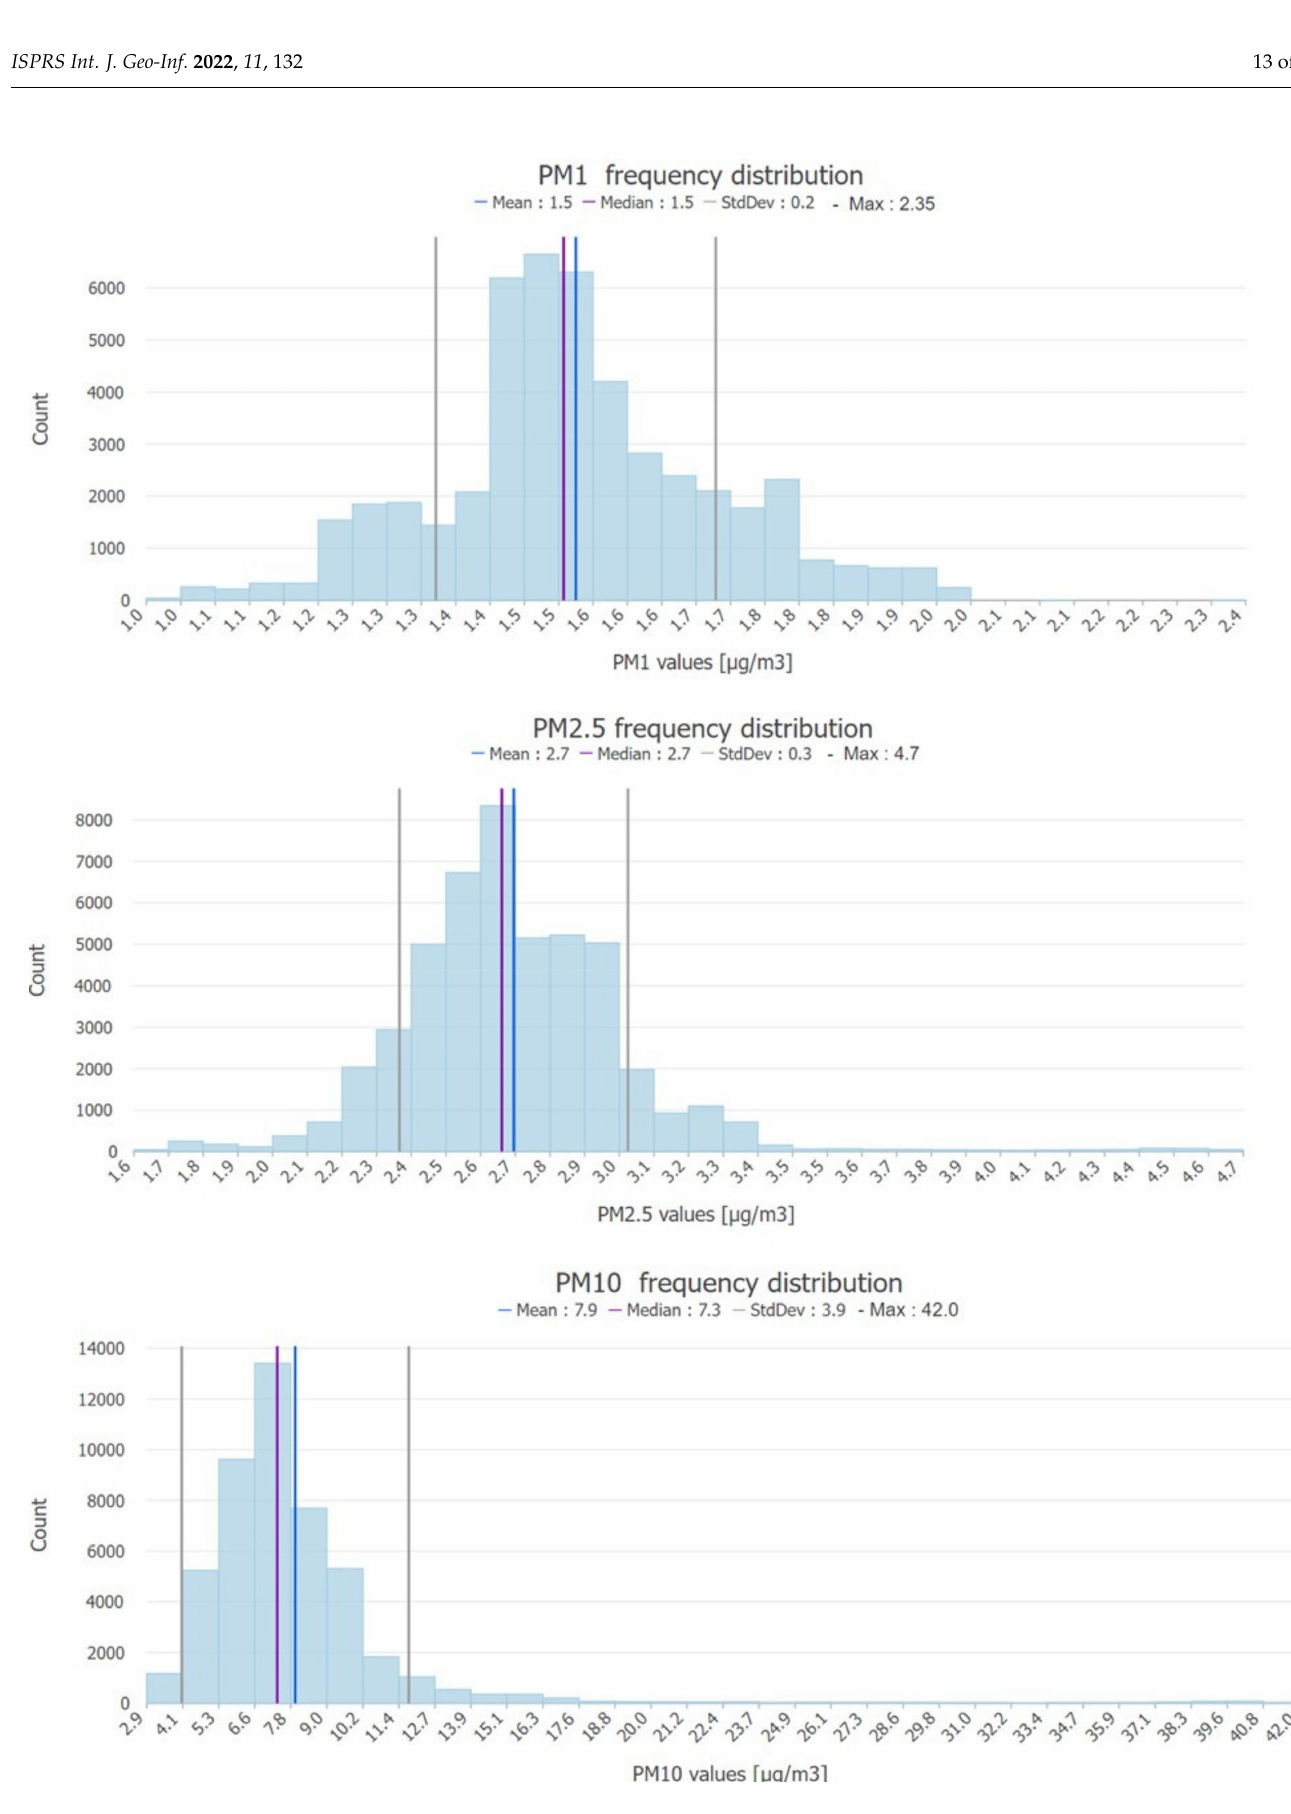
Figure 10. Frequency distribution of interpolated PM-1, PM-2.5, and PM-10 values in the area of